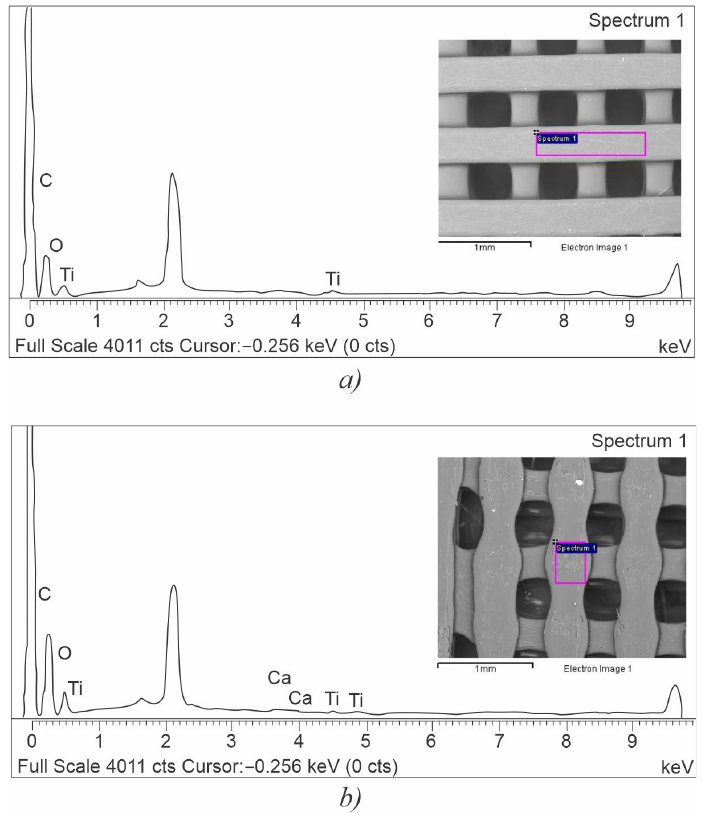
Table 2. EDS elemental composition values [Wt.%] of LLC and HLC scaffolds.